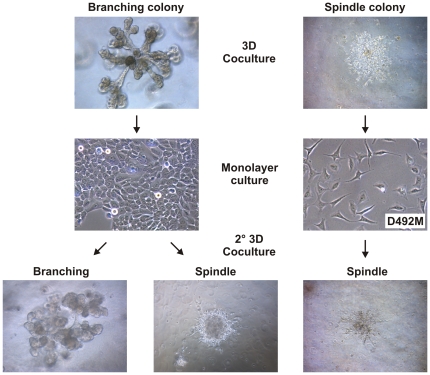
Isolation of D492-derived mesenchymal-like cells (D492M).Six branching and six spindle-like colonies were isolated and plated in monolayer culture. Cells from branching structures retain cuboidal epithelial phenotype in monolayer (left panel). When cocultured with BRENCs these cells generate branching TDLU-like (40%) and spindle-like colonies (50%) in secondary 3D culture (°2 3D). Cells from spindle-like colonies (right panel) showed mesenchymal/spindle like morphology in monolayer and cells isolated from one of these colonies gave rise to D492M. When cocultured with BRENCs these cells only gave rise to spindle like colonies in secondary 3D coculture.